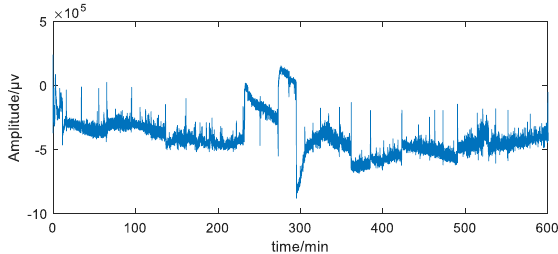
Figure 1. Overnight wearable PPG signal.